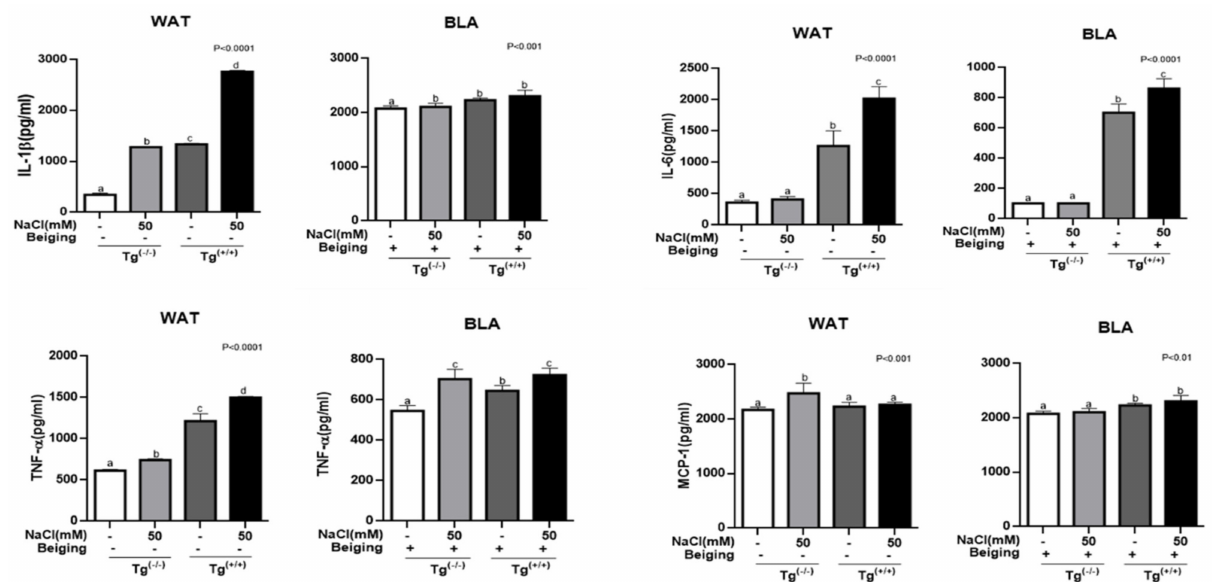
Figure 3. Beiging positively reduced the interactive effects of salt and the MEK6 gene on the production of inflammatory cytokines, such as TNF-alpha, IL-beta and IL-6, in WAT. Significant differences in individual treatments of WAT or BLA are indicated by ANOVA test with different superscript letters (a, b, c, d).